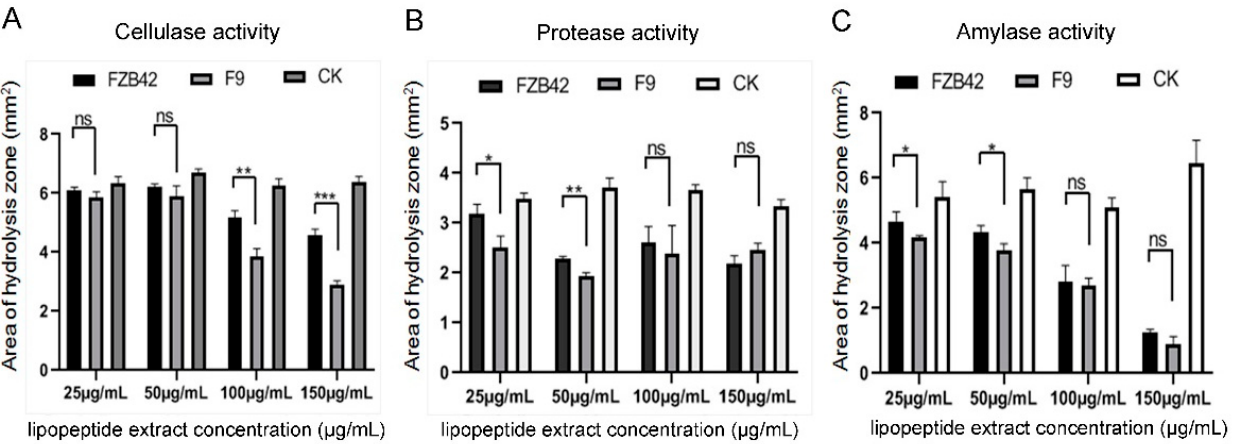
Figure 4. The effect of strain F9 and FZB42 antimicrobial lipopeptides on extracellular enzyme activity of Xcc jx-6. ( A ) The cellulase activity assay. ( B ) The protease activity assay. ( C ) The amylase activity assay. The effect of extracellular enzyme activity was qualitatively determined by means of a perforated dot plate. The area of the hydrolysis zone was measured using ImageJ. Error bars represent standard deviation. Mean values were analyzed and separated by Tukey’s HSD test at * p < 0.05, ** p < 0.01, *** p < 0.001, ns: no significance after one-way ANOVA. Error bars represent stand- ard deviation.